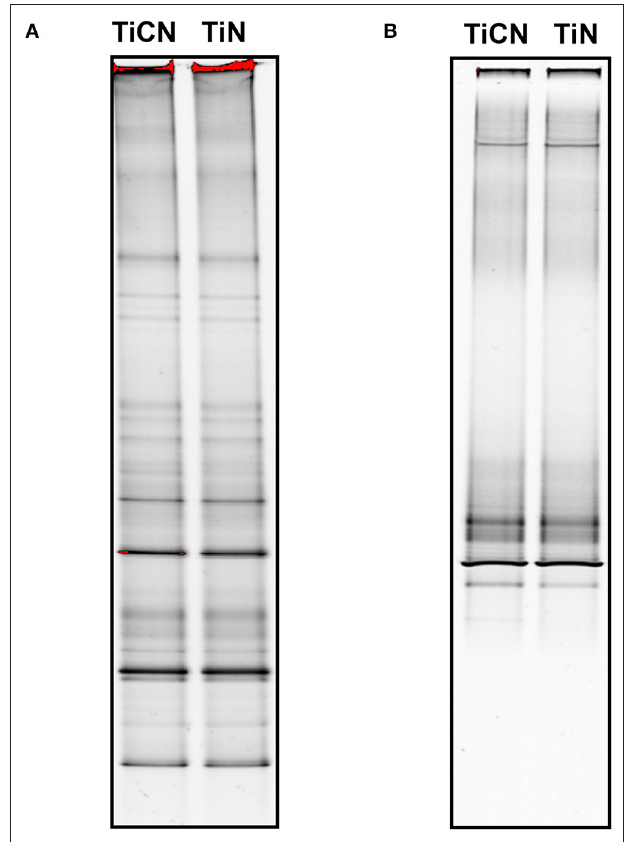
FIGURE 5 | Denaturing gradient gel electrophoresis (DGGE) profiles of the oral microbial biofilms on TiCN and TiN coatings grown in 50% SHI medium (A) in the absence (B) and presence of Scr and